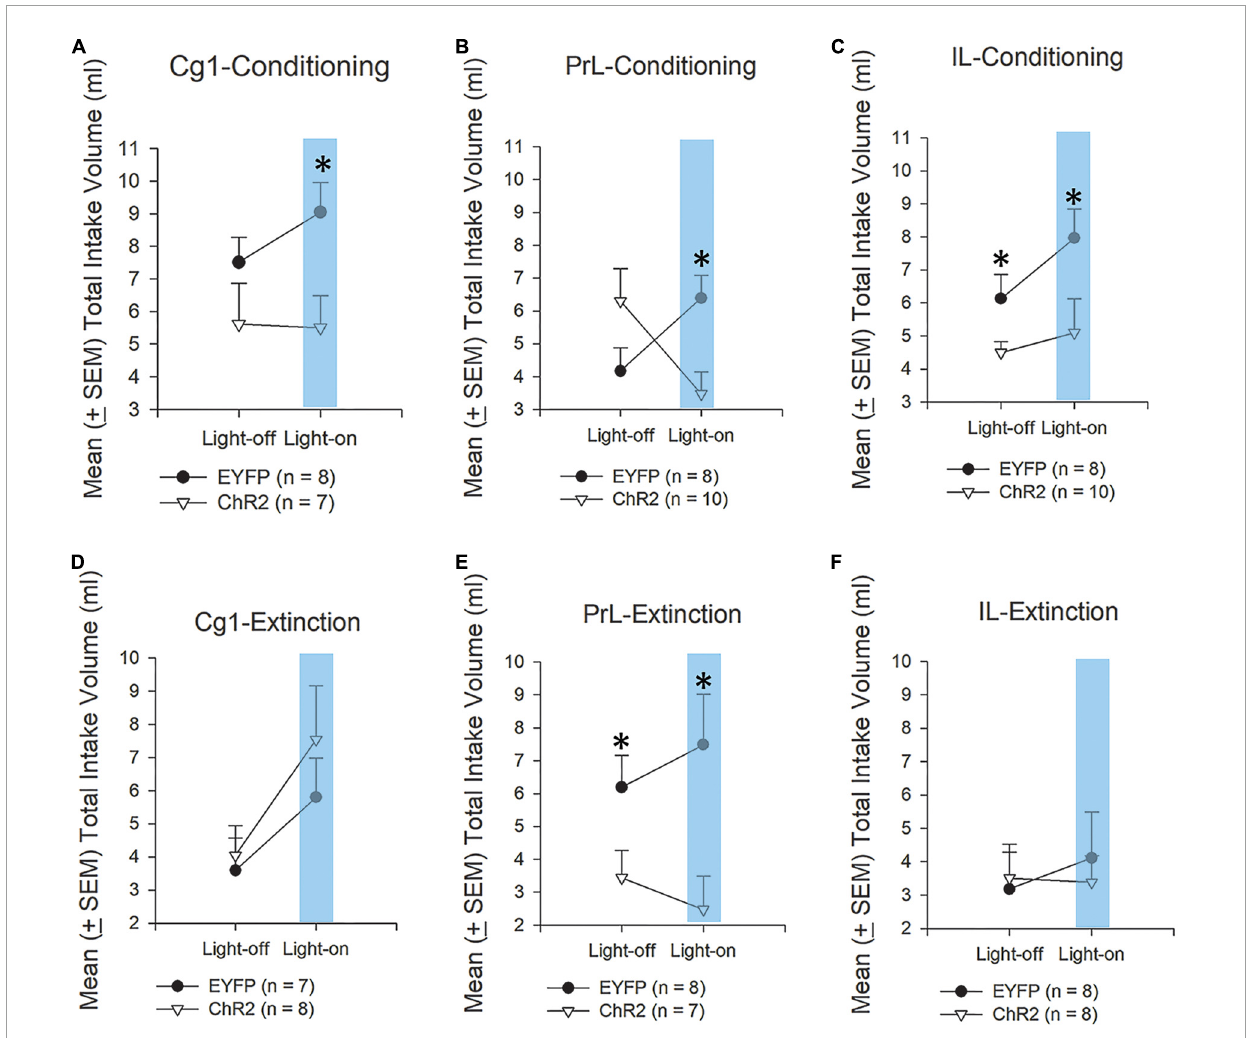
FIGURE4 Morphine acts as an aversive unconditioned stimulus (US) in CTA. Mean ( ± SEM) total intake volume of saccharin solution in rats injected with morphine under optical stimulation of the Cg1, PrL, and IL during conditioning (A–C) and extinction (D–F) ; 3-min light-on and 3-min light-off treatments were conducted over two sessions. In the CTA test, the rats were divided into EYFP ( n = 8) and ChR2 ( n = 7) groups. ∗ p < 0.05 indicates the ChR2 group compared with the EYFP group. Note that comparison of means for light-on conditions are therefore made up of 1 measure without CTA and one measure with